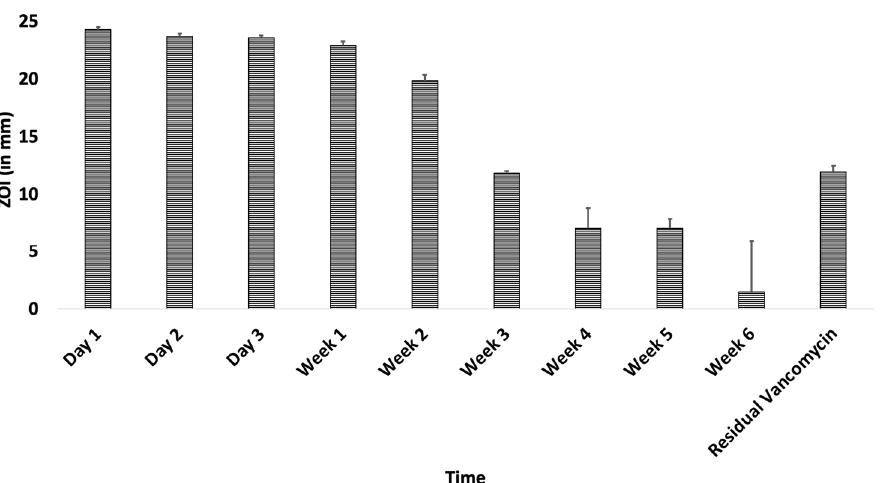
Figure 8. Zone of inhibition of released vancomycin from ABVF-BG putty against S. aureus (strain ATCC 49230). Released antibiotic at different timepoints showed bacterial killing. Residual antibiotic also showed bacterial killing.